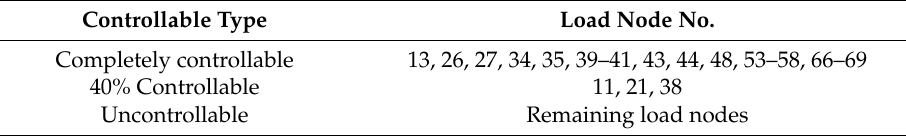
Table 3. Types of load controllability.